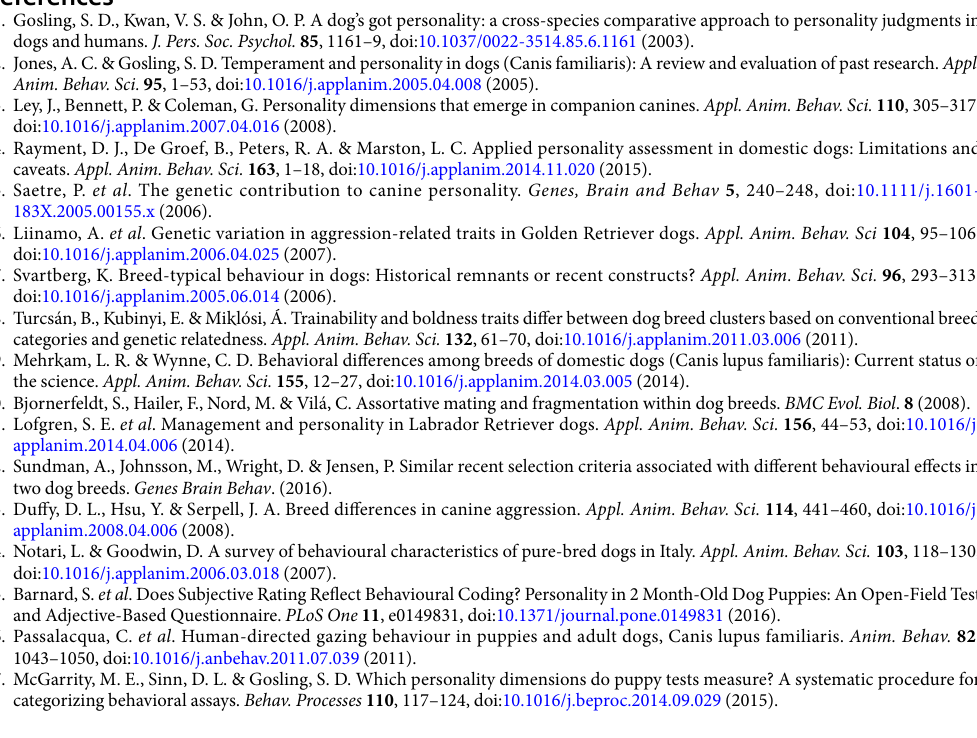
With the aim to investigate breed, litter and sex effects on each of the personality traits identified by the cluster analysis, we applied a Generalized Linear Mixed Model (GLMM) running a dredge model selection procedure, using the R package MuMin to identify the best model (Akaike Information Criterion). Starting from a null model, we added the random effects nested into the litter factor and the fixed effect of breed, sex and litter and their interaction. Details of the procedure applied can be found in the Supplementary Information. To allow a general profiling and overview of our different breeds, mean and 95% confidence interval (CI) were calculated. This allowed assessing how each breed differed from the population mean on each personality trait. One-sample t-test was used to calculate significant p-values ( α ≤ 0.05). R (3.3.2) statistical programmes were used for all the analysis.